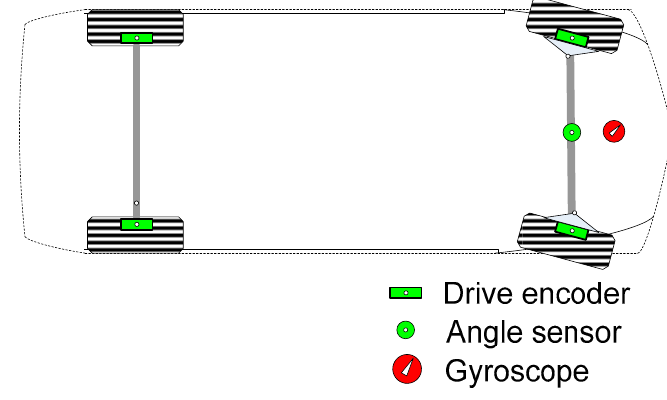
Figure 1. Vehicle sensor configuration.